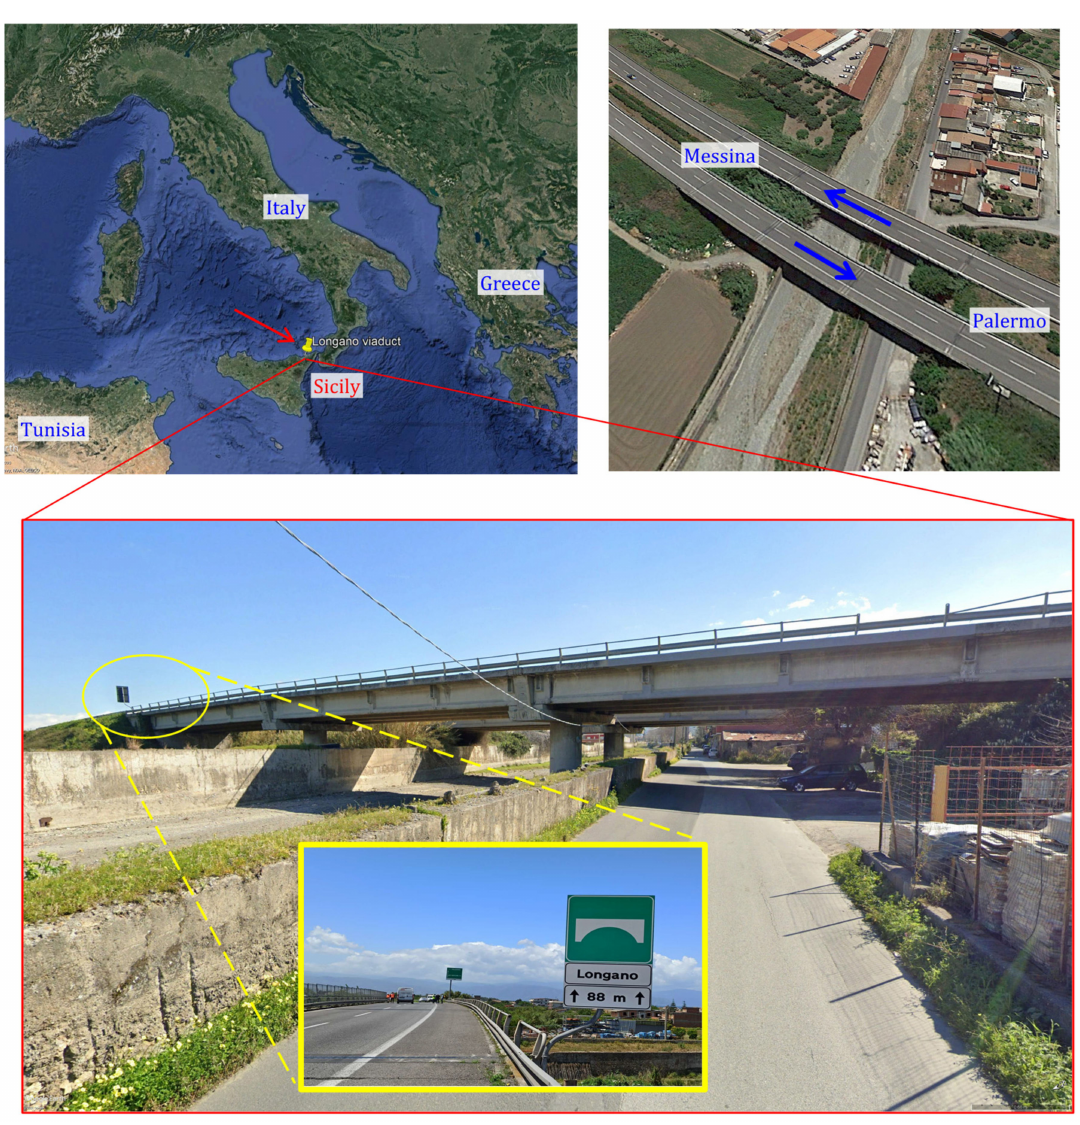
Figure 1. Location and photograph of the Longano viaduct, Barcellona P.G., Italy analyzed in this paper as a case study. (Base map © 2021 Basarsoft US Department of State Geographer Data, U.S. Navy, GEBCO Image